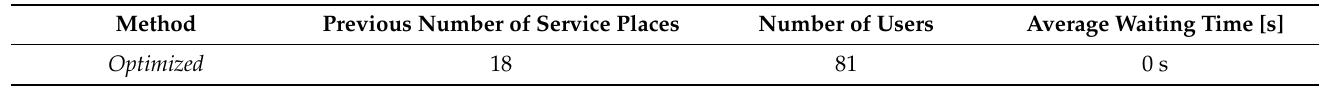
Table 7. The results of searching for an optimal number of service capacities for an increased user quota U = 81 with the proposed method.